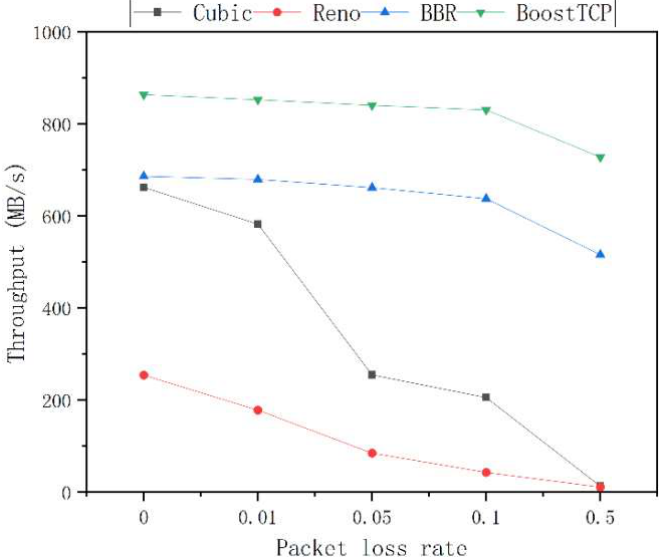
Figure 6. The throughput curves of the four congestion control algorithms as a function of the packet loss rate at a network delay of 30 ms.